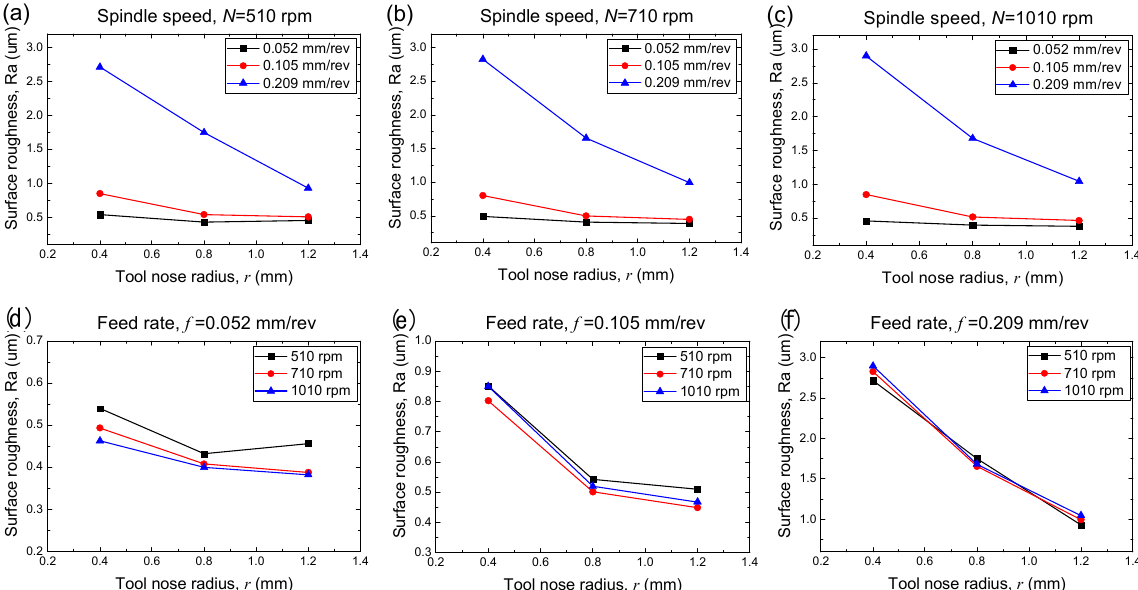
Figure 2. Effect of spindle speed ( N ) and feed rate ( f ) on surface roughness (R a ) for using different tool nose radii r 1 , r 2 and r 3 .